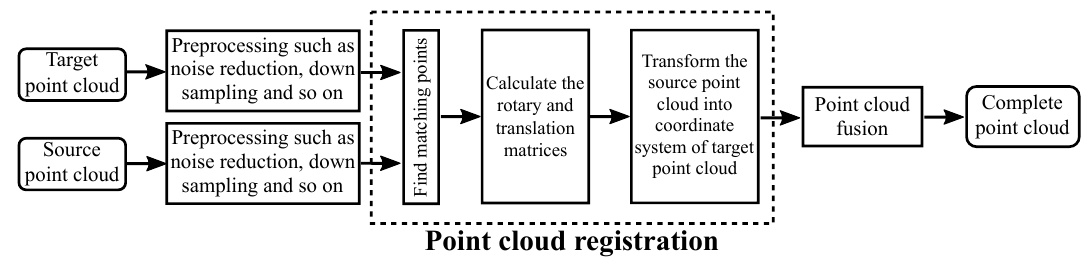
Figure 1. The flow chart of point clouds